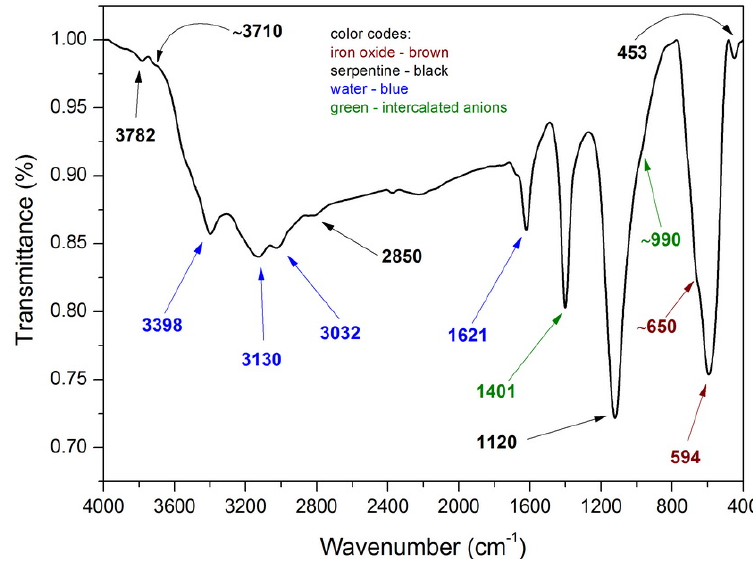
Figure 3. Fourier transform infrared spectroscopy (FTIR) spectrum of MNP/SP composite.